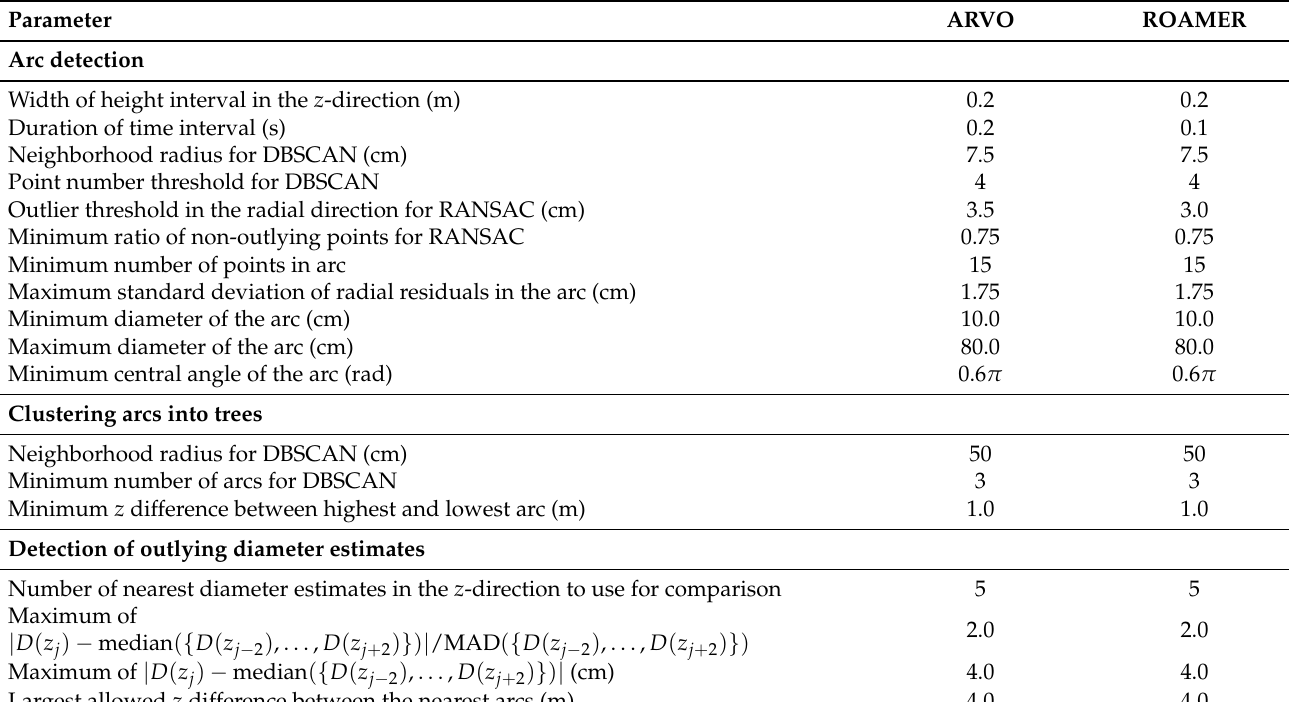
Table 2. The most important parameters for the stem curve estimation algorithm. In the table, MAD refers to the median absolute deviation that has been scaled, such that it estimates the same population quantity as the standard deviation in the case of the normal